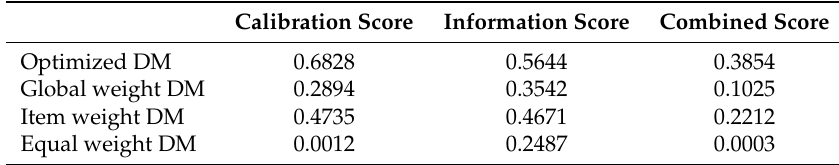
Table 6. Performance of the different Decision Makers for all 62 experts.